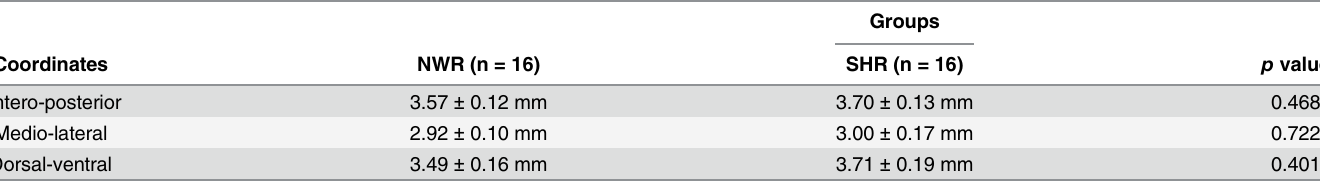
Table 2. Antero-posterior, medio-lateral, and dorsal-ventral coordinates at which the thermistor tips were positioned in the brains of SHRs and